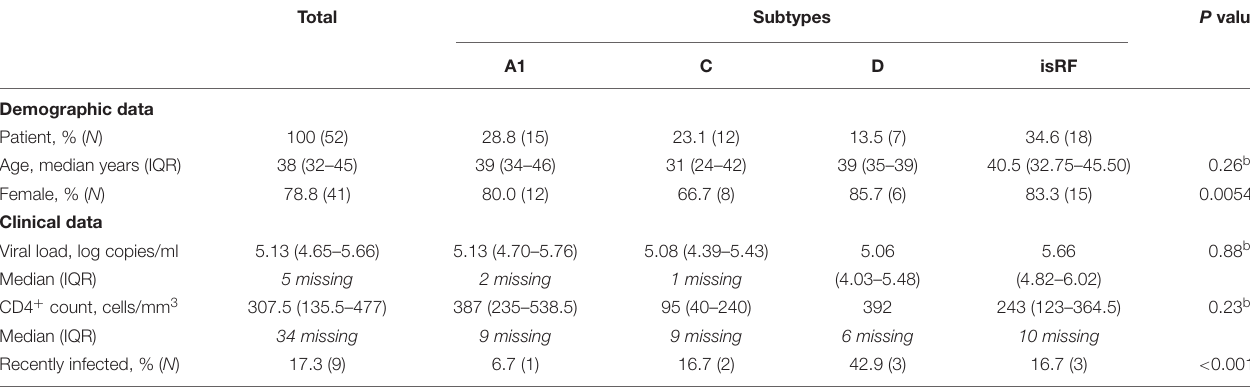
TABLE 1 | Summary of demographic, clinical, and viral